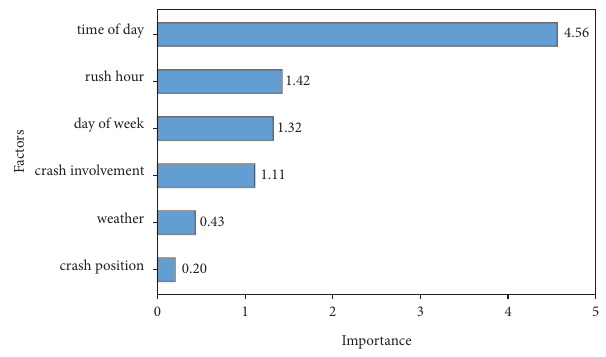
Figure 6: The importance of various risk